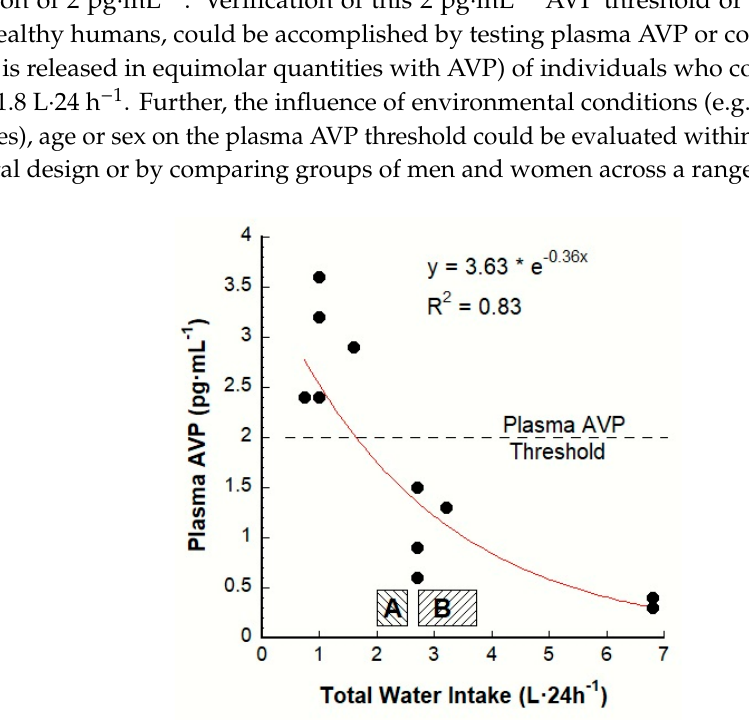
Figure 2. The relationship between daily total water intake (all sources) and plasma AVP concentration, based on 11 published laboratory investigations. The plasma AVP threshold of 2 pg · mL − 1 [41] occurs at a TWI of 1.8 L · 24 h − 1 , which is approximately 64 total oz of water per day. Low volume drinkers and water-deprived adults appear as the 5 data points above the plasma AVP threshold. See text for details. The range of adequate intakes for women and men appear as zone A (European Food Safety Authority [10]) and zone B (U.S. National Academy of Medicine [11]). .